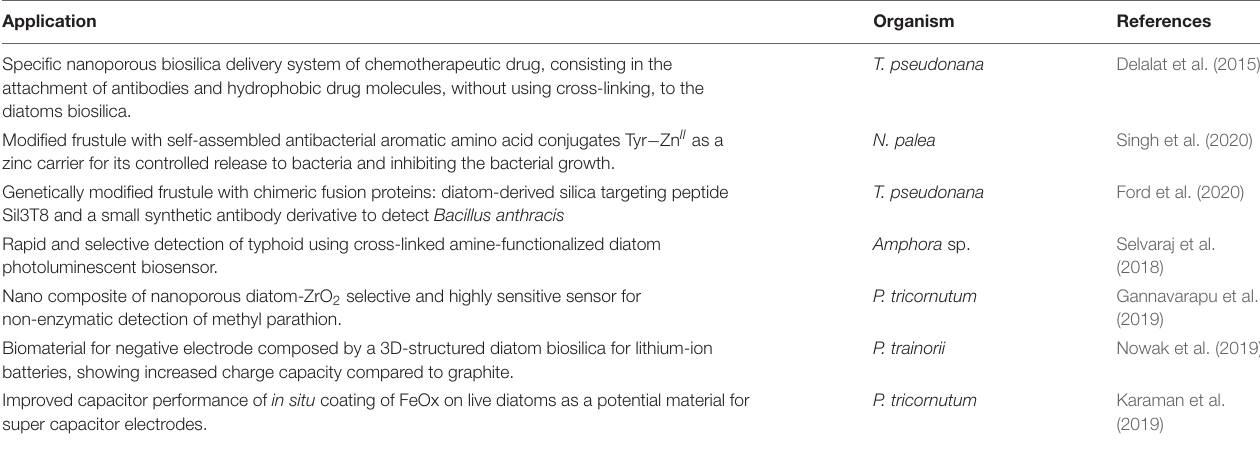
TABLE 2 | Biomedical applications of diatom silica-based materials using different diatom species.